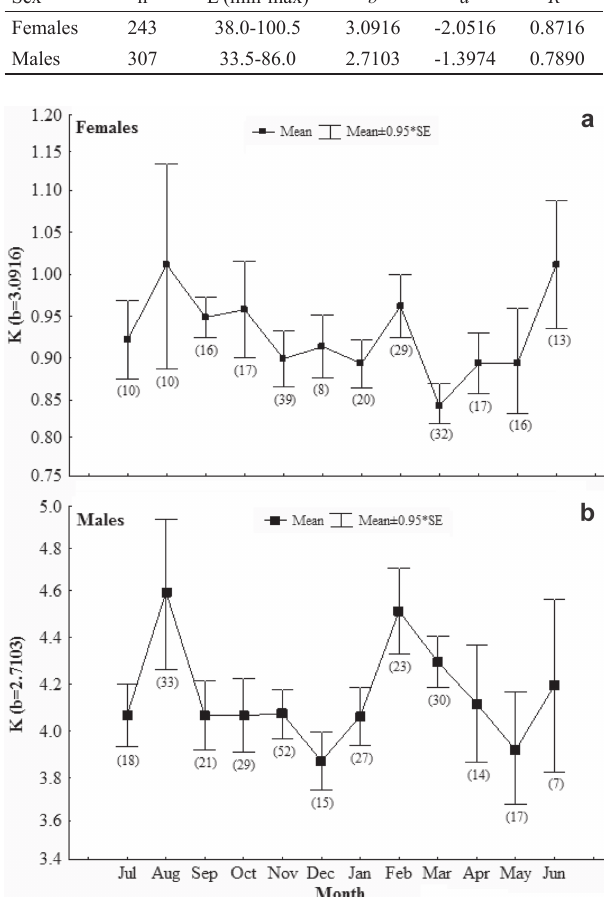
Fig. 4. Allometric condition factor (mean ± SE) of females and males of Salminus brasiliensis at different sampling months in the Upper Uruguay River (between April 1996 and February 2014). The number of individuals used in each month is in parenthesis. a. Females; b. Males.